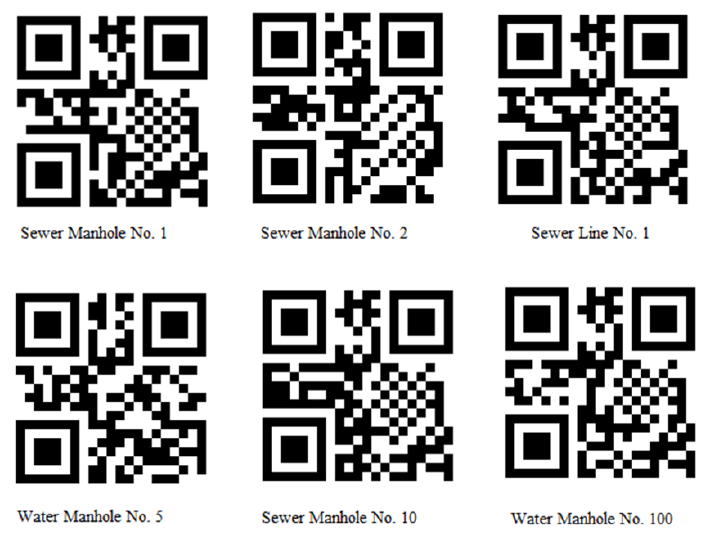
Fig. 10. Examples of some generated QR